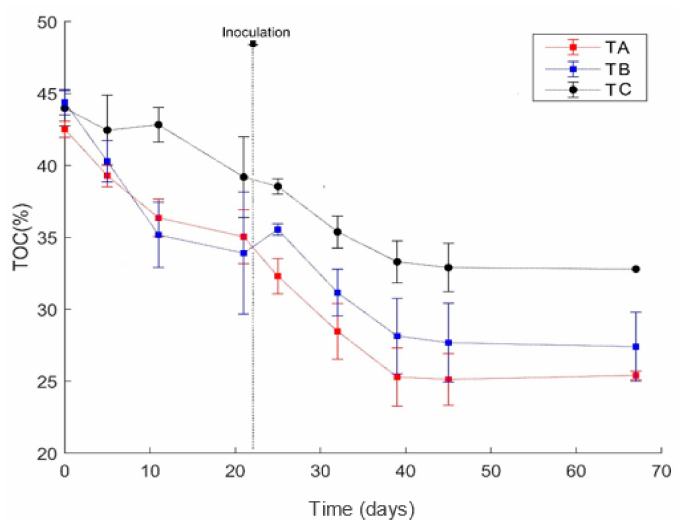
Figure 3. TOC changes during the composting